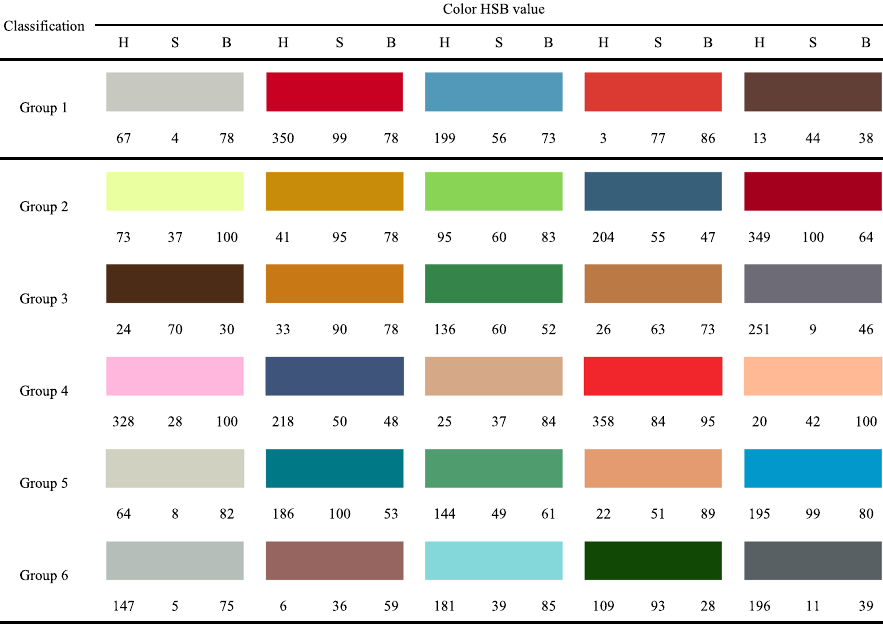
Table 1. Product color grouping and color HSB